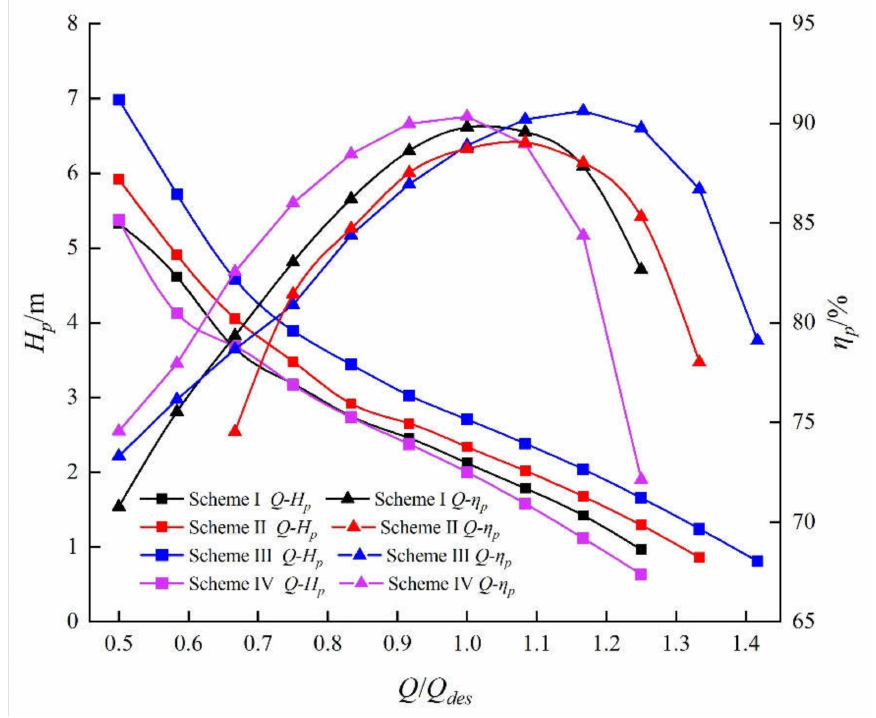
Figure 12. Hydraulic performance curve of axial-flow pump impeller in different